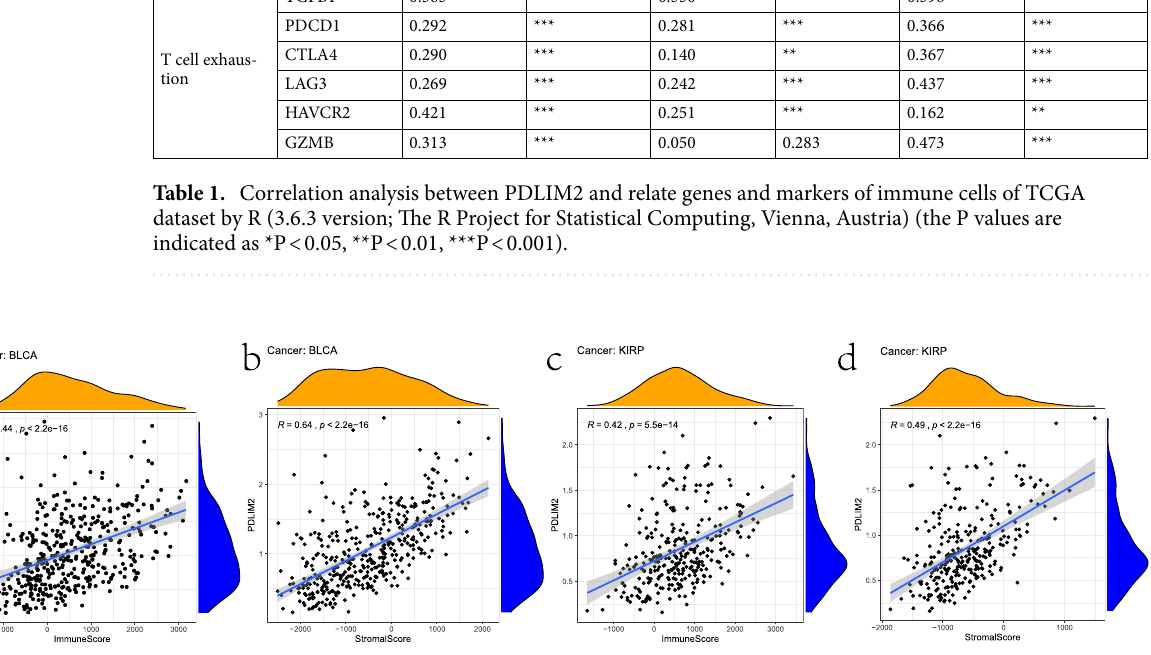
Figure 6. Correlation between PDLIM2 and immuneScore and Stromal Score of TCGA dataset by R (3.6.3 version; The R Project for Statistical Computing, Vienna, Austria). in BLCA and KIRP, ( a ) correlation between PDLIM2 and immuneScore in BLCA, ( b ) correlation between PDLIM2 and Stromal Score in BLCA, ( c ) correlation between PDLIM2 and immuneScore in KIRP, ( d ) Correlation between PDLIM2 and Stromal Score in KIRP; BLCA: bladder urothelial carcinoma; KIRP: kidney renal papillary cell carcinoma.